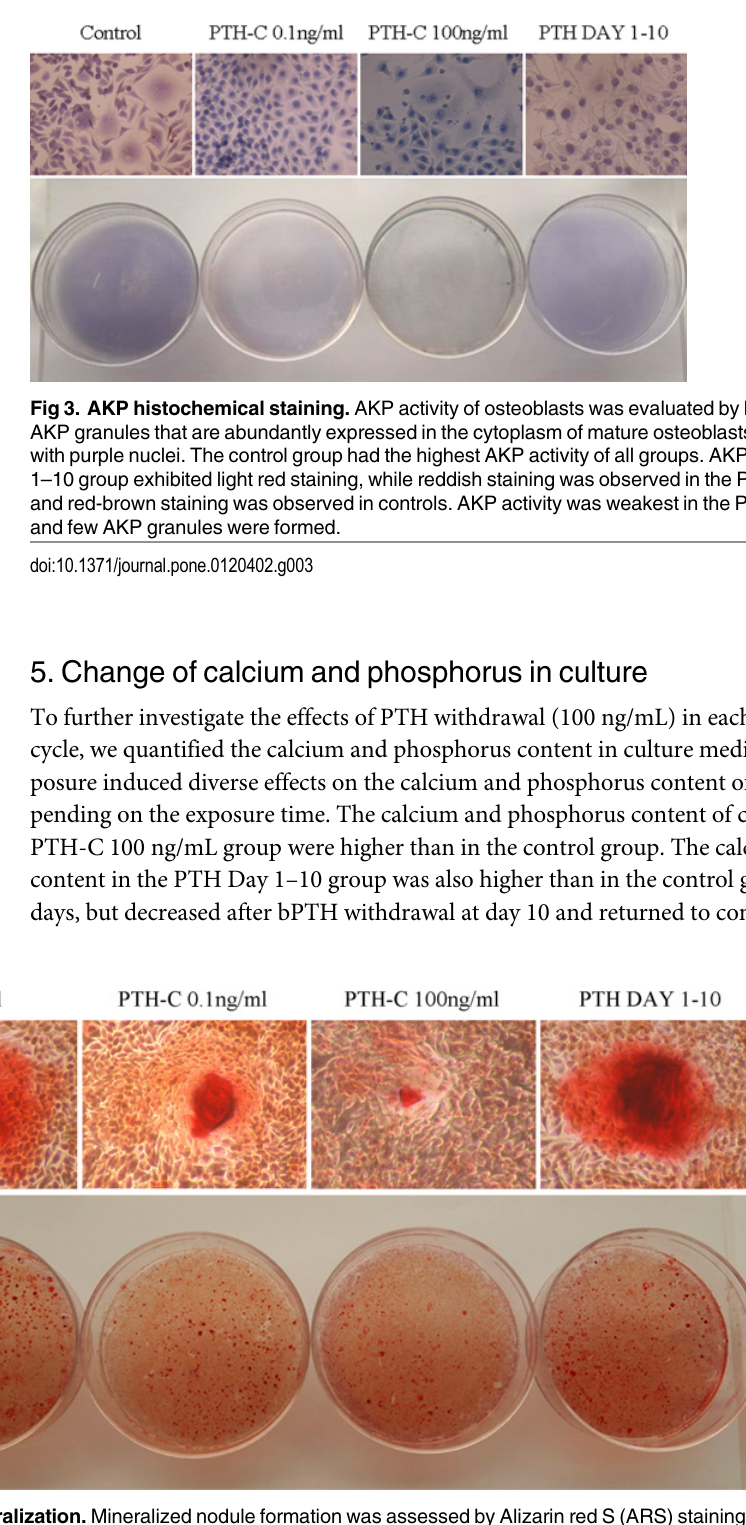
Fig 4. Effects of PTH withdrawal on mineralization. Mineralized nodule formation was assessed by Alizarin red S (ARS) staining 20 days after differentiation. The blank control group without the supplement of bPTH and the osteogenic induction in the cell culture was performed as a negative control. Original magnification